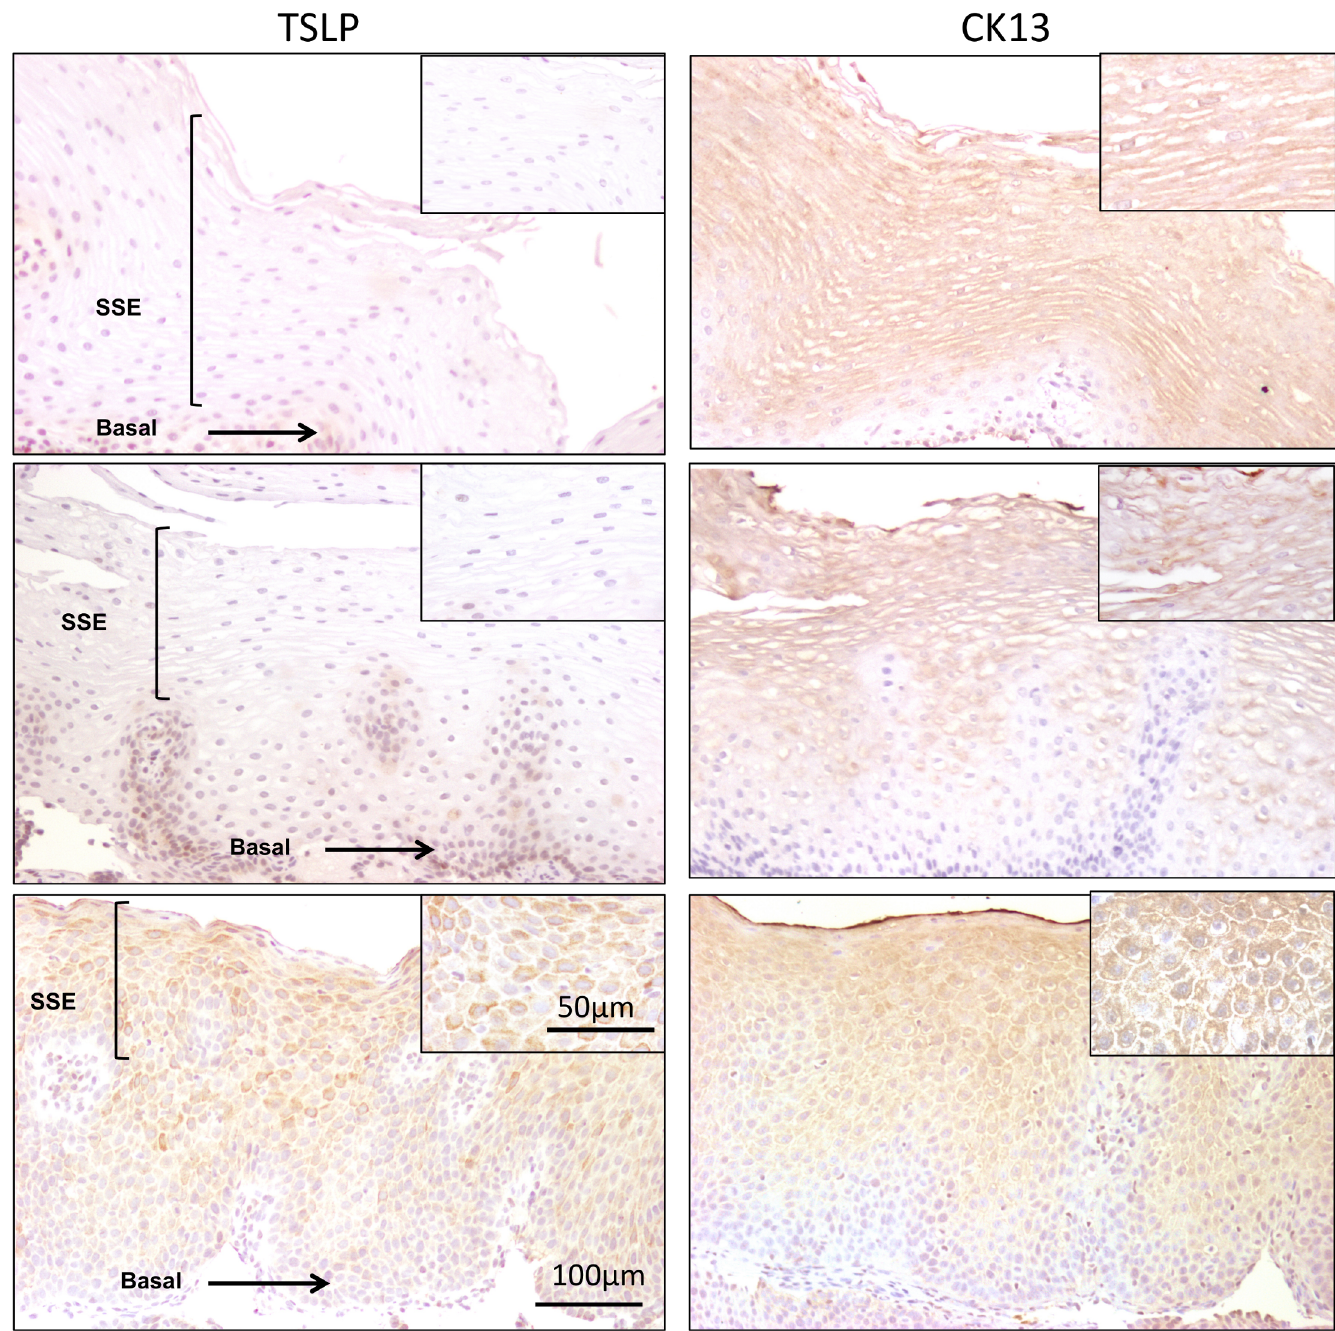
Fig 1. TSLP expression is restricted to the suprabasal differentiated compartment of the esophageal epithelium. Immunohistochemistry for TSLP (A, C,E) and cytokeratin 13 (CK13) (B,D,F) in esophageal pinch biopsies from representative non-EoE control subjects, subjects with inactive EoE ( < 15 eosinophils per hpf), and active EoE ( (cid:1) 15 eosinophils per hpf). 200X magnification. Larger images represent 100X magnification. The box represents the area chosen for 200X magnification in the smaller side panel. SSE = Stratified squamous epithelium; B = Basal epithelium.